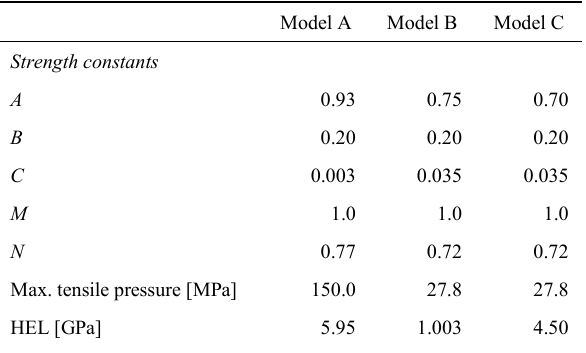
Table 1: Model parameters for float glass determined by different authors for the Johnson-Holmquist (JH-2) ceramic